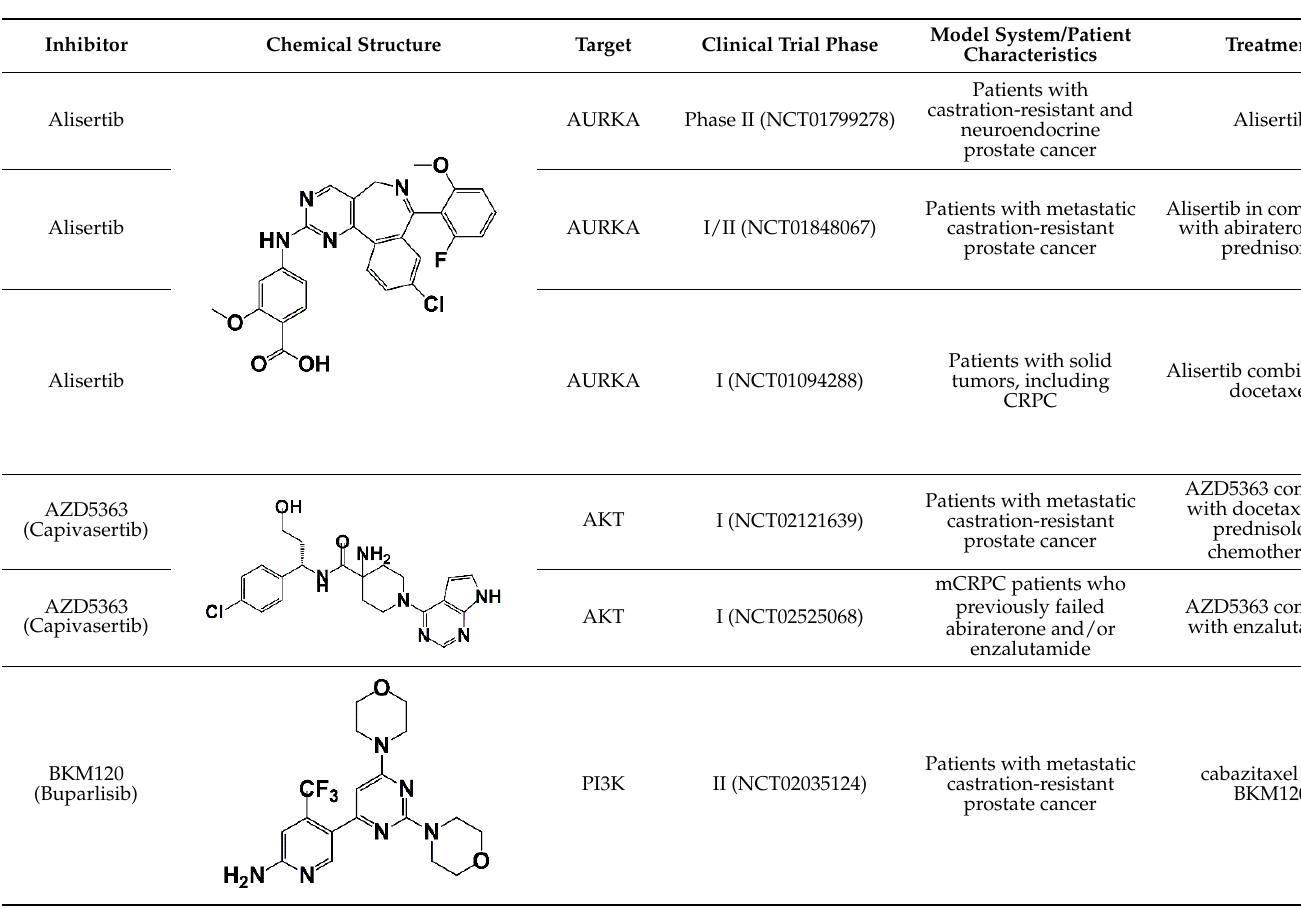
Table 2. Kinase inhibitors for CRPC in clinical trials.